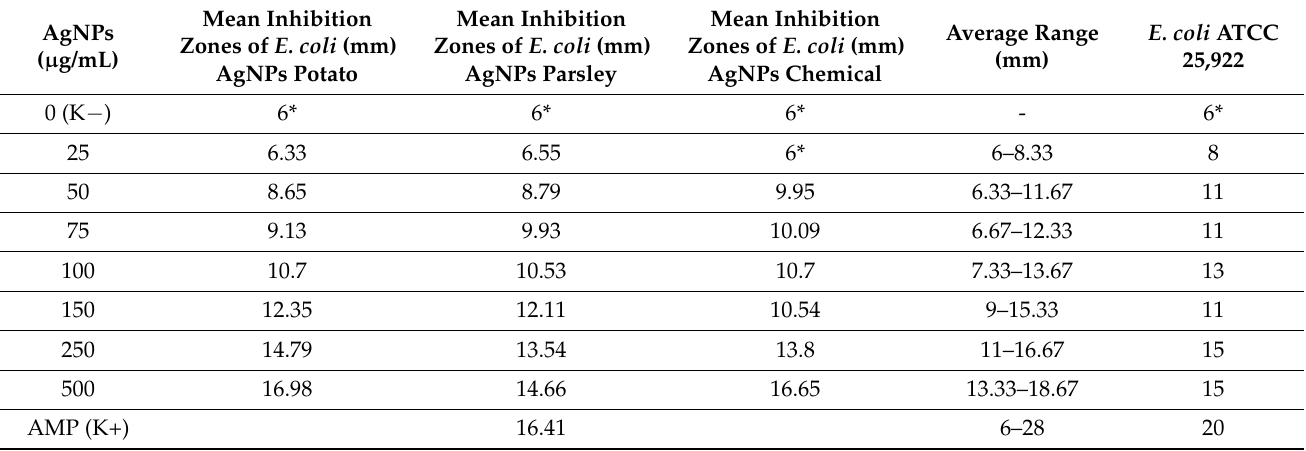
Table 2. Antibacterial activity of nanosilver on E. coli and ampicillin as a positive